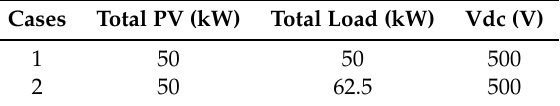
Table 3. Single PV operation scenario.